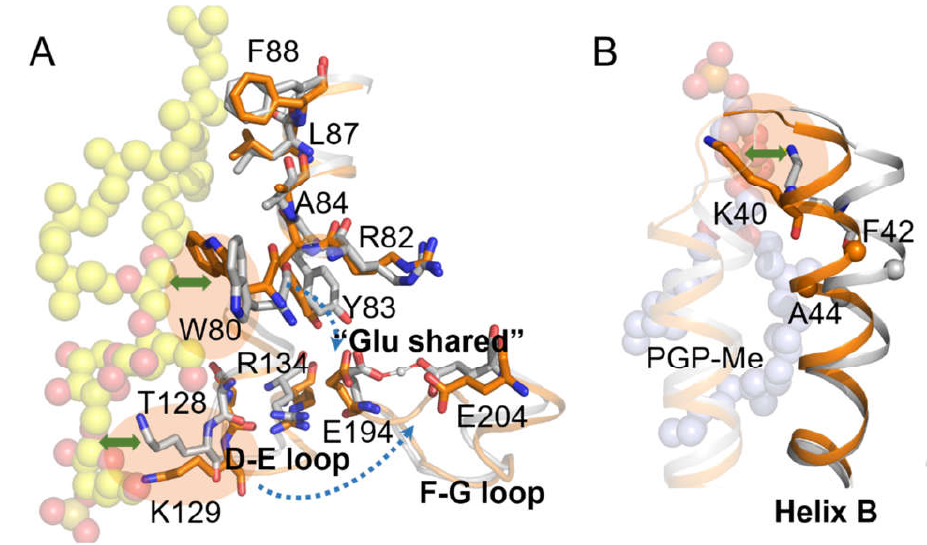
Figure 11. Schematic flowchart of the effects of S-TGA-1 ( A ) and PGP-Me ( B ) on the extracellular and cytoplasmic surfaces of bR. Yellow and light-blue spheres represent S-TGA-1 and PGP-Me, respectively. Grey and orange sticks indicate the regional conformation of bR and lipids in M1 and M2, respectively; green bidirectional arrows represent the specific interactions between residues and lipids, and blue dashed arrows indicate the regulatory role of W80 and K129 on the “Glu-shared” model.